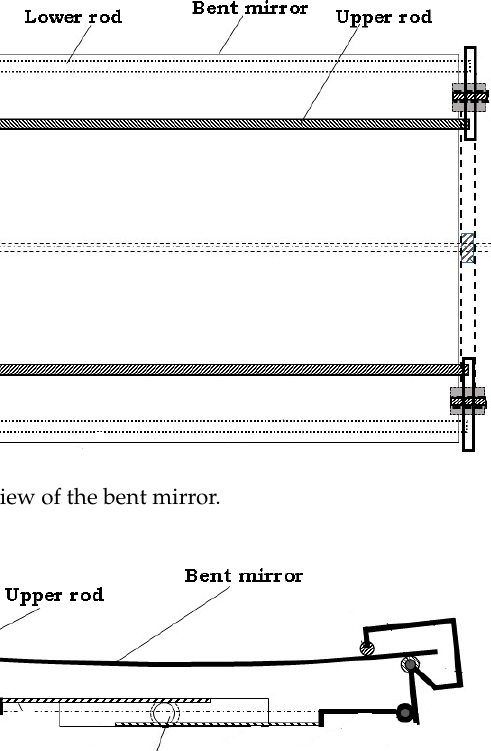
Figure 7. Cross-section of a mirror bent by means of torque applied to both lateral sides with lateral levers.